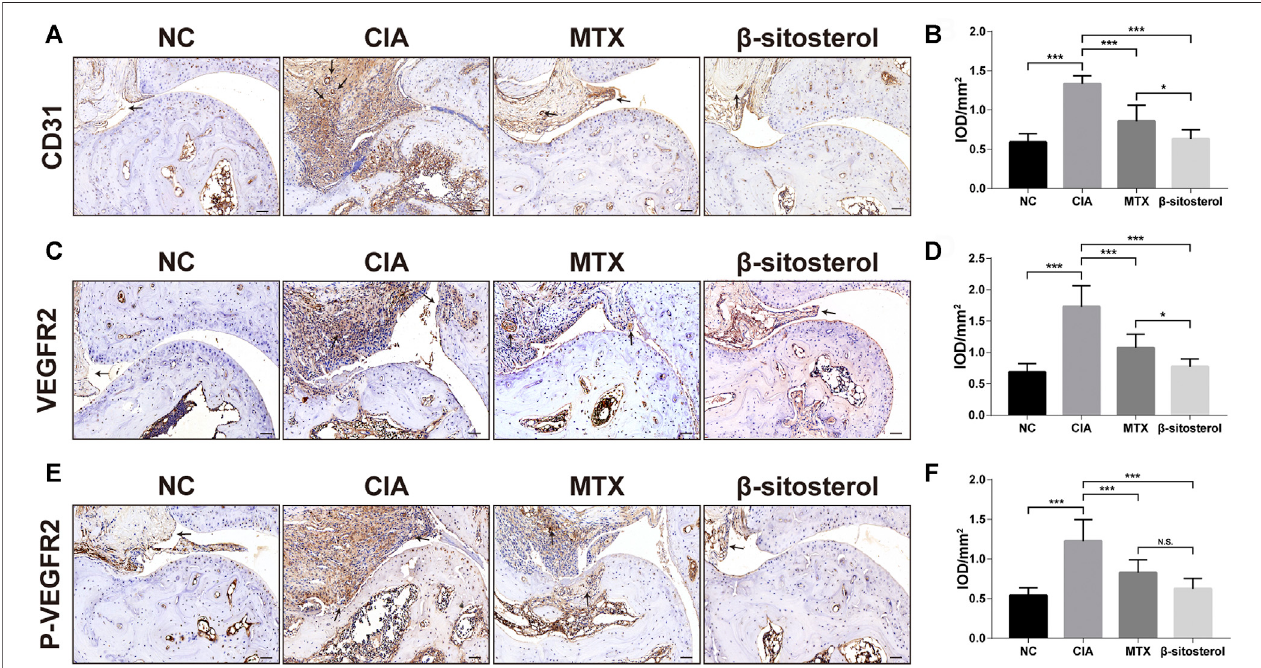
FIGURE 6 | Effect of BSS on immunohistochemistry of CD31, VEGFR2, and P-VEGFR2 on experimental arthritis. (A) CD31 immunohistochemical staining of the ankle joints in each group, and the optical density value (B) analysis using ImageJ ( n = 6) (×200, scale bar = 50 μ m). (C) VEGFR2 immunohistochemical staining of the ankle joints in each group, and the optical density value (D) analysis using ImageJ ( n = 6) (×200, scale bar = 50 μ m). (E) p -VEGFR2 immunohistochemical staining of the ankle joints in each group, and (F) the optical density value analysis using ImageJ ( n = 6) (×200, scale bar = 50 μ m). All data are shown as the mean ± SEM. * p < 0.05, ** p < 0.01, *** p < 0.001, n.s. = not signi fi